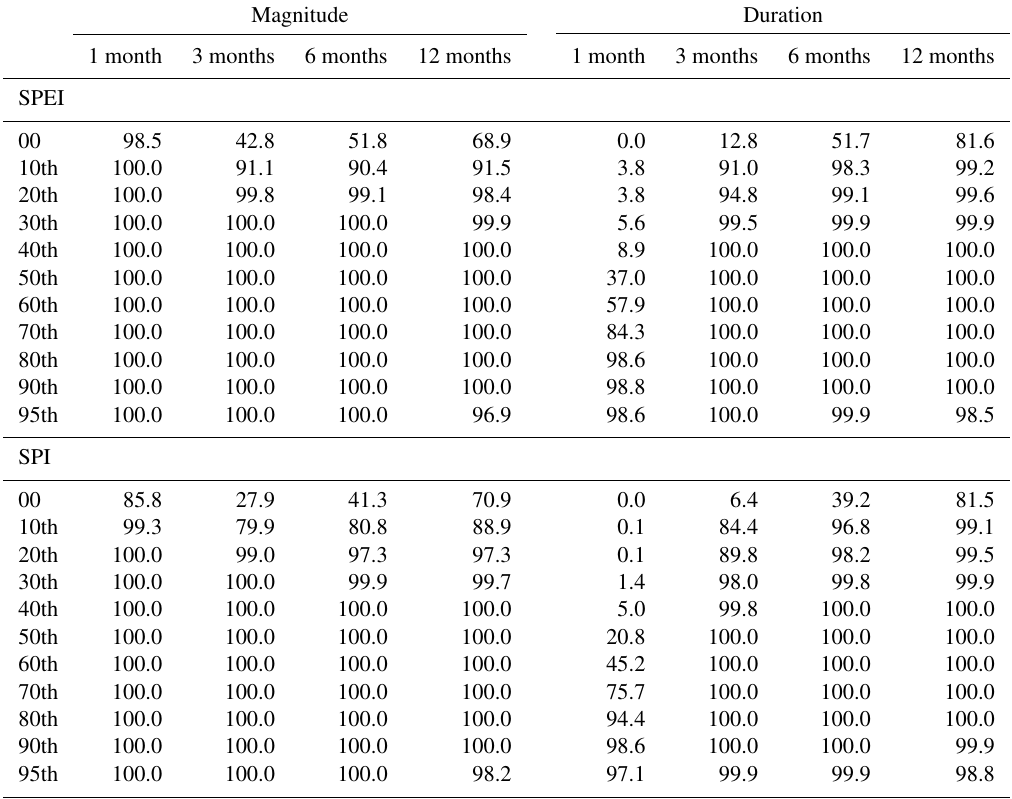
Table 1. Percentage of the peak-over-threshold drought duration and magnitude series that fit well with the generalized Pareto distribution following Anderson–Darling statistics. Results are summarized for different percentiles and timescales using SPEI and SPI.